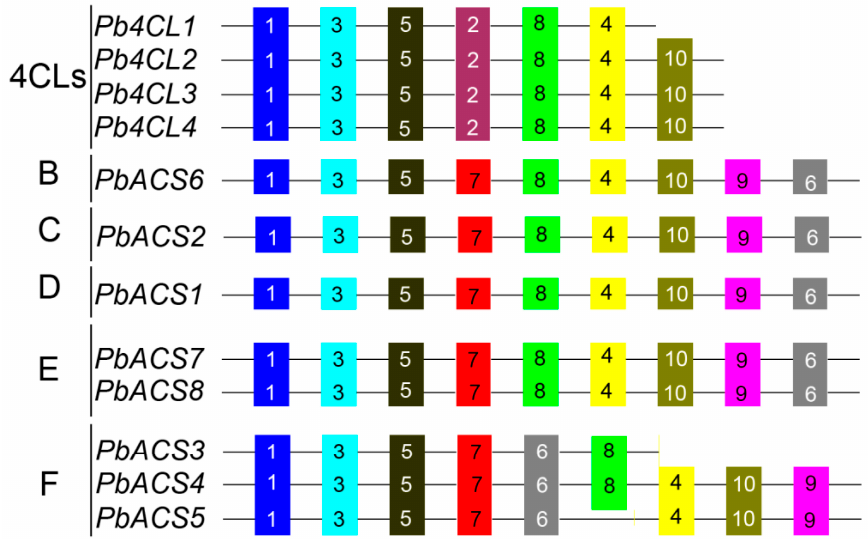
Figure 5. Distribution of conserved motifs in pear 4CL and ACS numbers. Motifs of 4CL and ACS proteins were identified with the Multiple Expectation Maximization for Motif Elicitation (MEME) online tool. Note that the length of each box in the proteins does not represent the actual motif size, and different motifs are indicated by different colored boxes based on results of the MEME analysis.